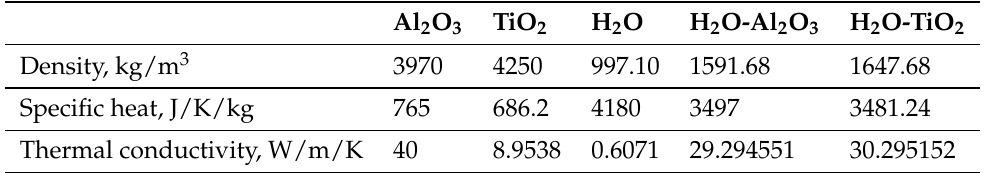
Table 5. Comparative properties of water, nano-particles, and nanofluids at T = 390 K and ϕ = 0.2.